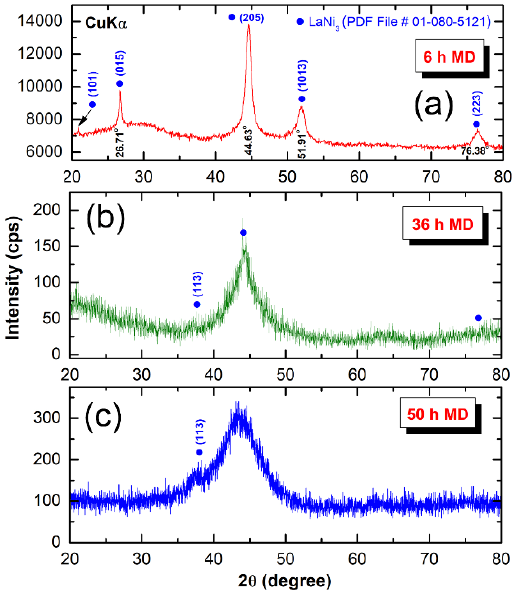
Figure 2. XRD patterns of arc-melted LaNi 3 intermetallic compound obtained after high-energy ball milling under He-gas atmosphere for ( a ) 6 h, ( b ) 36 h and ( c ) 50